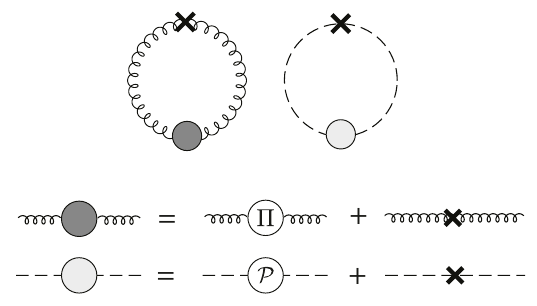
Figure 3 . Three-loop vacuum diagrams contributing to the SYM 1 , 10 free energy.